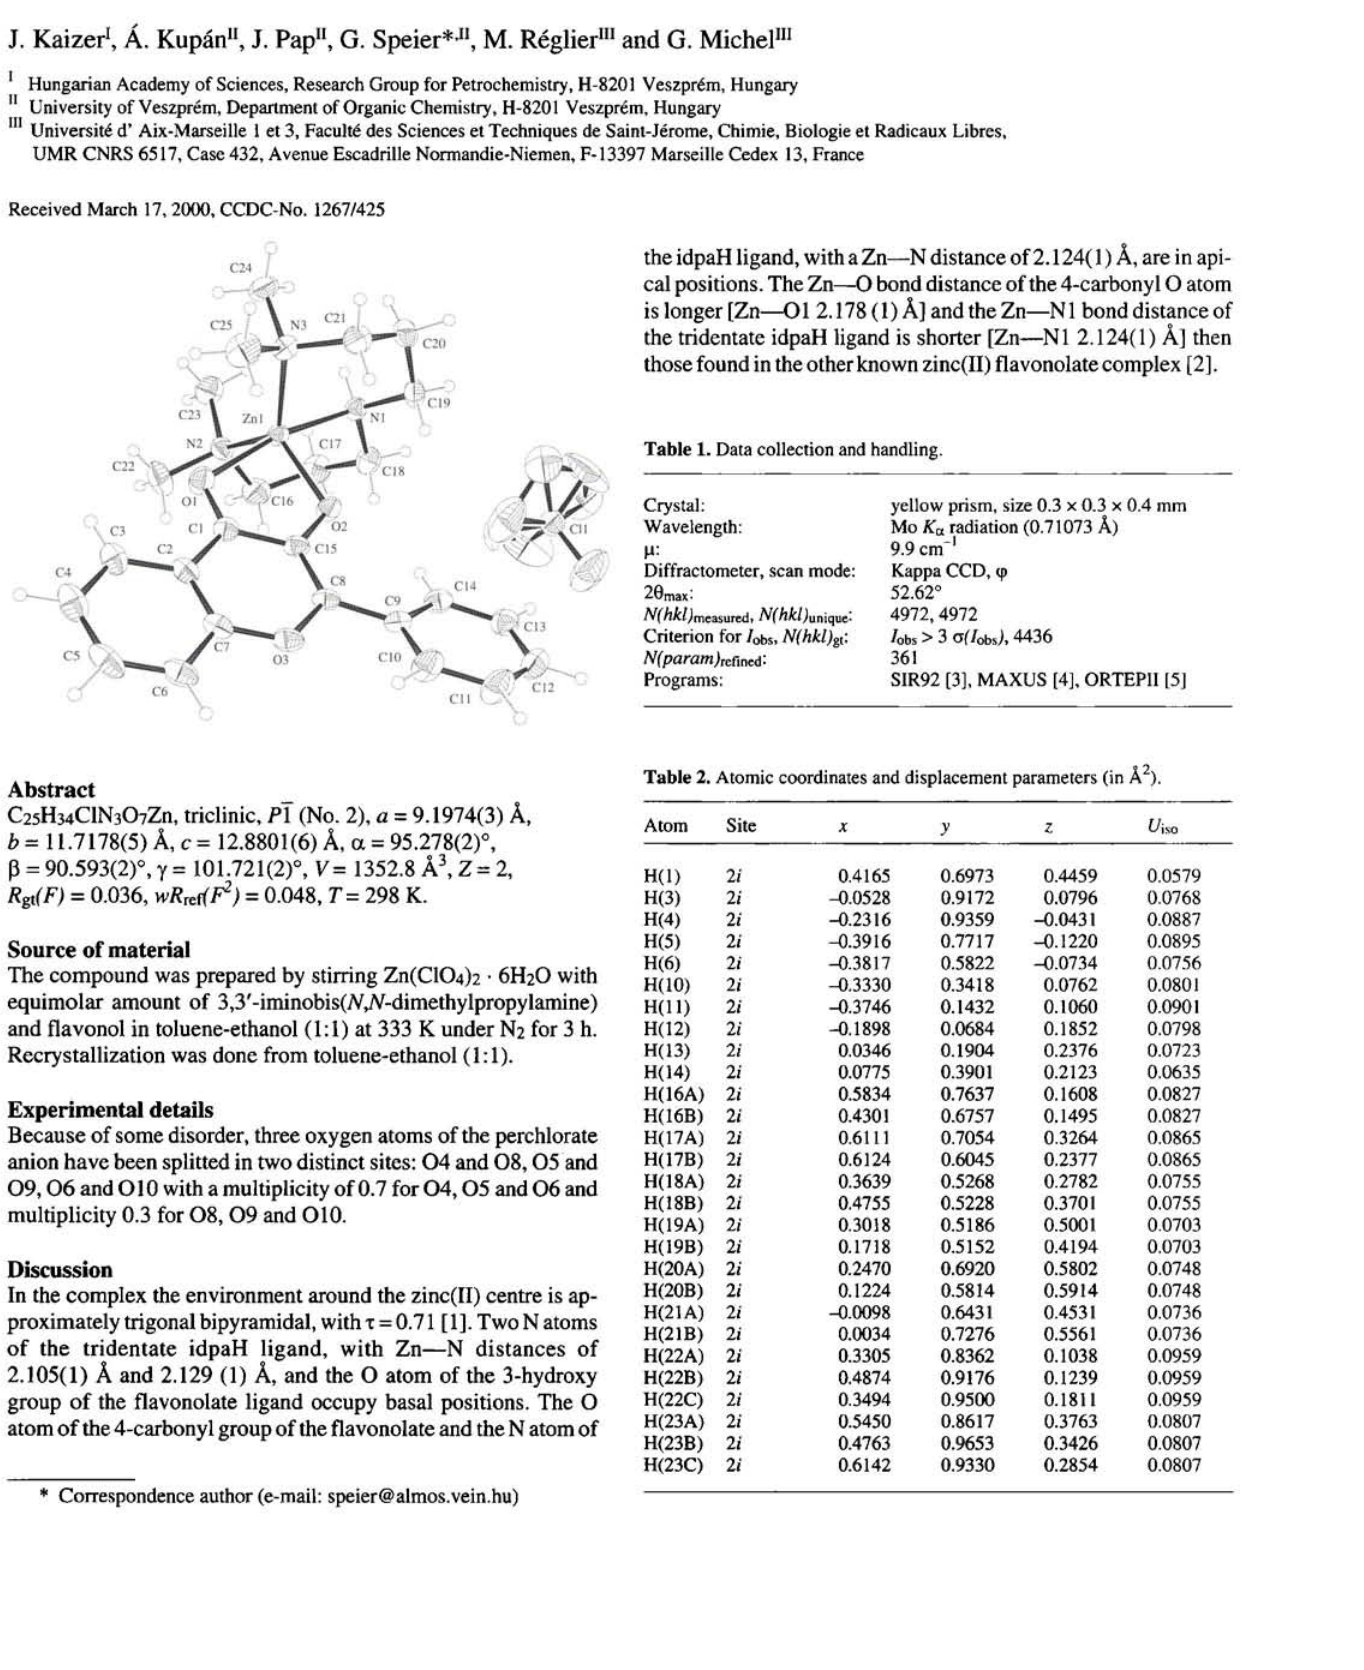
Table 1. Data collection and handling.